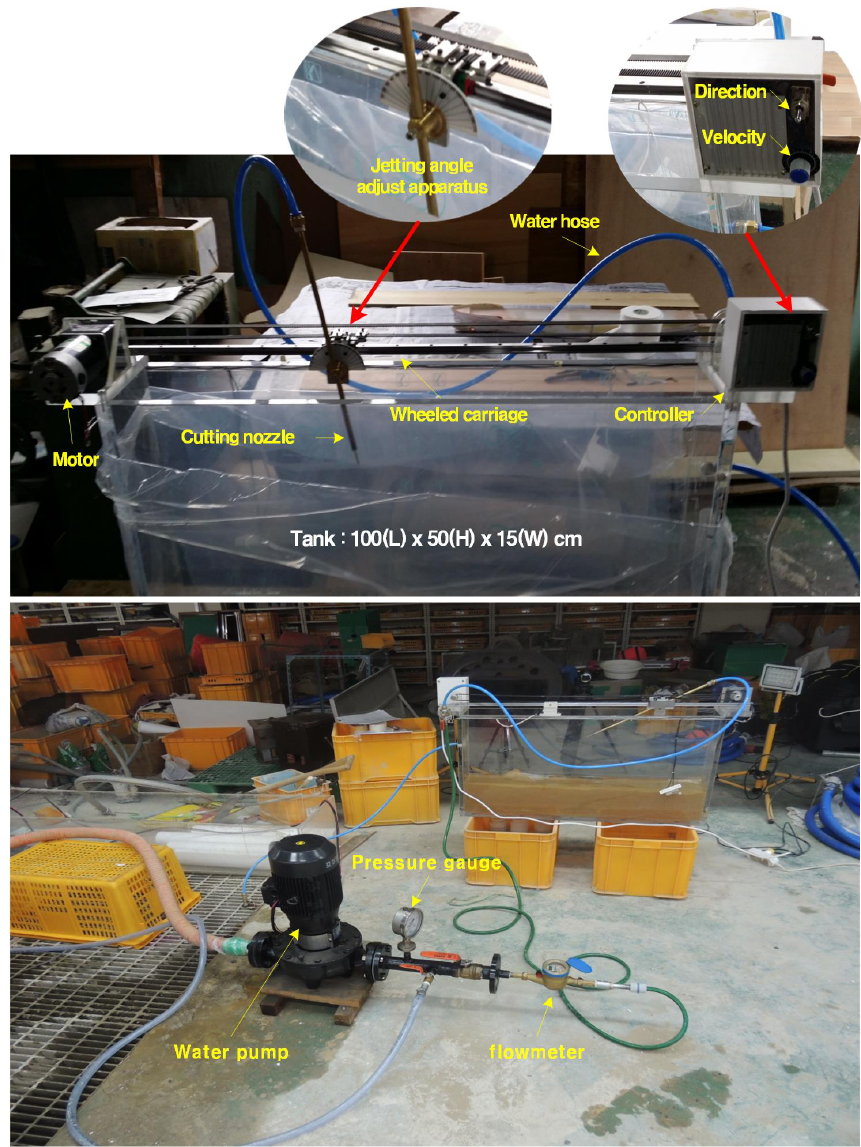
Figure 3. Laboratory experimental apparatus